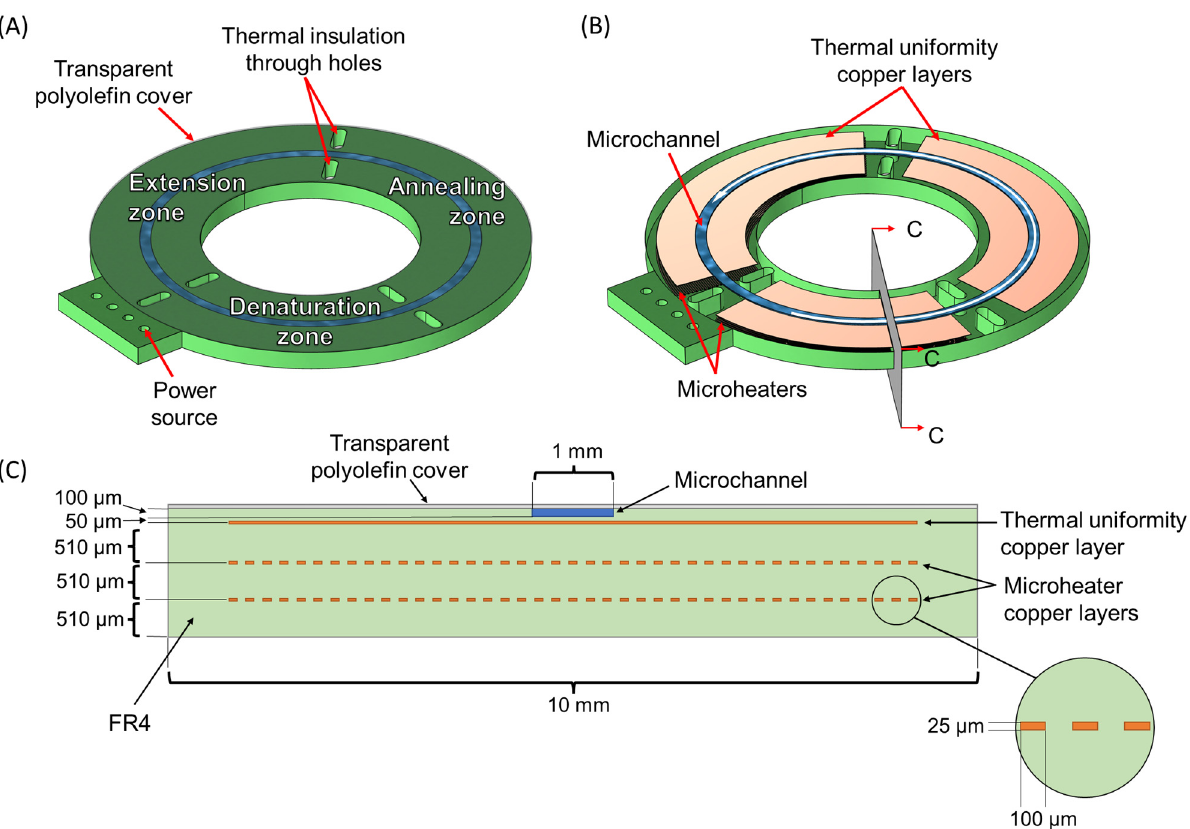
Figure 2. CL microreactor geometry. ( A ) External view of the microreactor with the circular microchannel covered by a thin polyolefin film. ( B ) Internal view of the microreactor. The sample is flowing through the microchannel following a counterclockwise direction (white arrow) along the three temperature zones of the PCR. ( C ) Cross-section of the microreactor with the C-C plane. The microheaters and thermal uniformity copper layers are integrated.